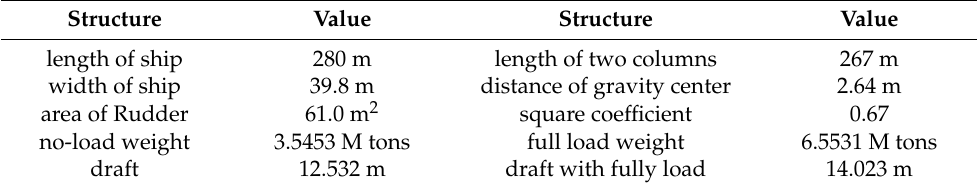
Table 2. Structure data of 5446 TEU container vessel. Structure Value Structure